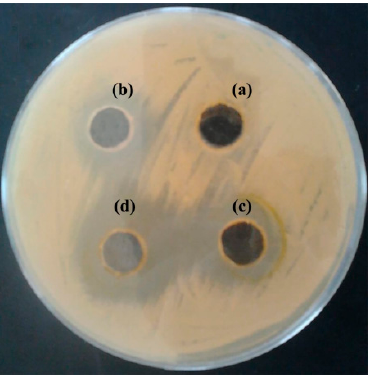
Figure 3. The inhibition zone of essential oil of S. officinalis L. leaves against S. enterica , at a concentration of ( a ) 0% represents the negative control, ( b ) 1% v / v ( c ) 2% v / v, and ( d ) 5% v / v in dimethylsulfoxide (DMSO).